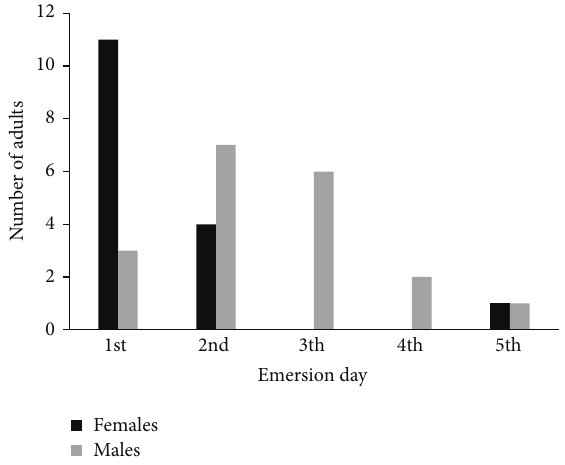
Figure 1: Number of Cosmosoma auge imagoes (both sexes) that emerged in each emersion day. Specimens were raised under labo- ratory conditions at Coj´ımar, Havana (September-October 2011).